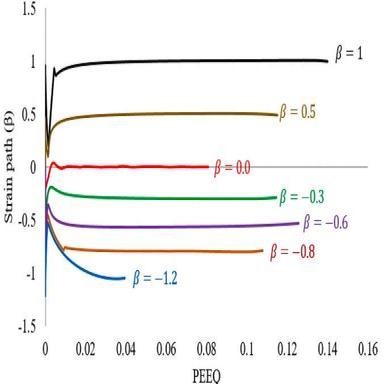
Controlled strain paths by FEM + PID method.